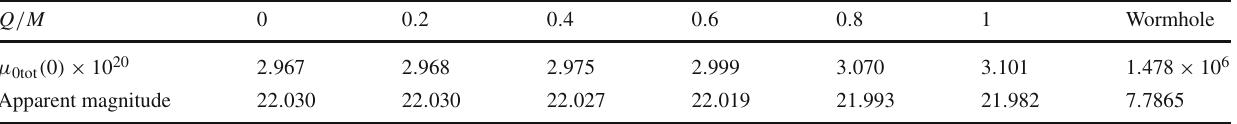
Table 3 Retro lensing with deflection angle (1.5): The total mag- nification μ 0tot ( 0 ) and apparent magnitude of the sun lensed by a photon sphere at D ol = 0 . 01pc We have assumed M = 60 M (cid:10)